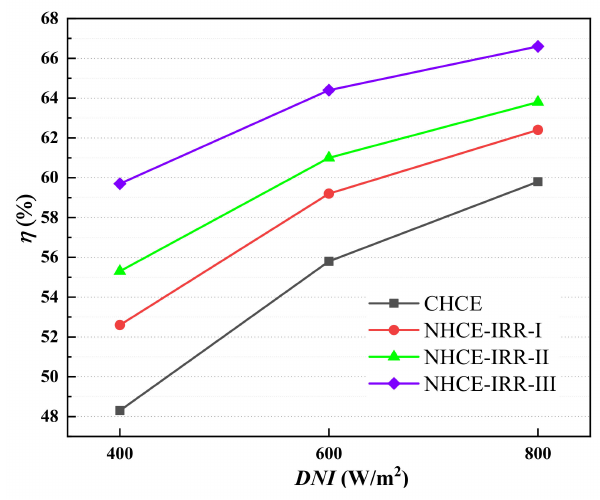
Figure 11. Energetic e ffi ciency of PTC system with di ff erent HCEs versus